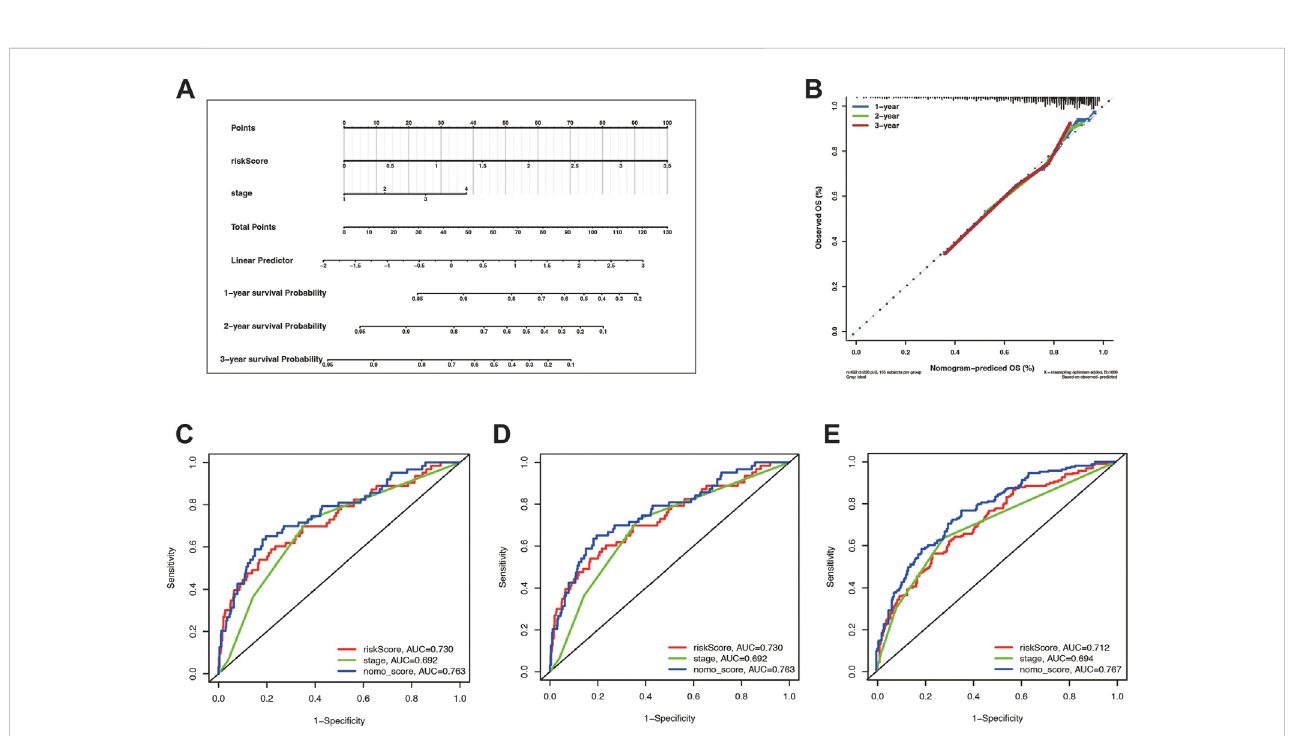
FIGURE 7 The risk score combining stage showed a better prognostic prediction power. (A) Nomogram with a total score of risk score and stage predicting the overall survival time was drawn in the merge cohort. (B) The calibrationcurve showed the difference extent betweennomogram-predicted OS and observed OS. (C – E) were the timeROCs for features including risk score, stage, and nomo_score in 1, 2, and 3 year overall survival time,